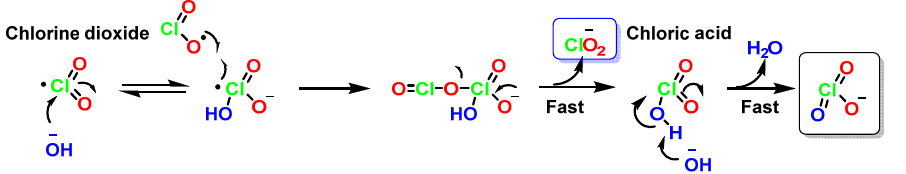
Figure 8. Molar stoichiometry from ClO 2 to ClO 2 − .